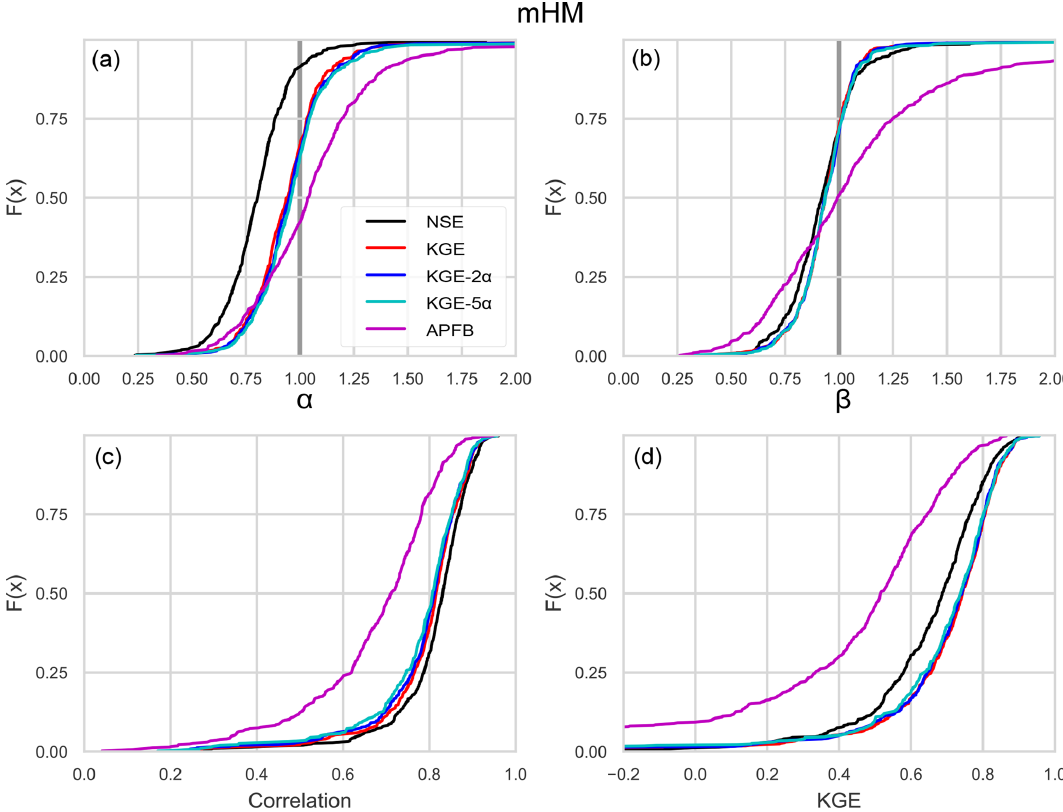
Figure 3. The same as Fig. 2 except for the